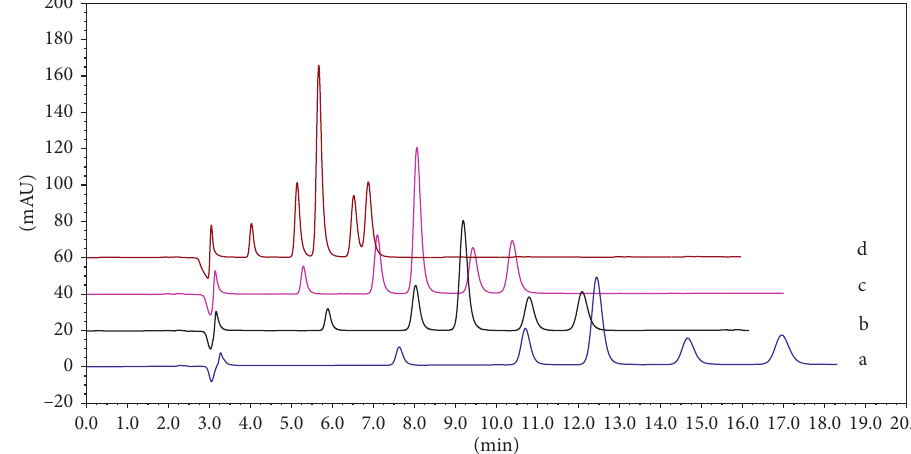
Figure 3: Typical HPLC chromatogram for simultaneous separation of ODT, GNT, TPT, AZT, and RMT. Chromatographic conditions were acetonitrile-0.05 mol · L − 1 potassium dihydrogen phosphate (phosphoric acid to adjust pH to 4.0), except the acetonitrile content was varied: (a) acetonitrile content 20; (b) acetonitrile content 25; (c) acetonitrile content 30; and (d) acetonitrile content 35. Table 1: Regression equation, correlation coefficient ( r ), linear range, and detection limit of the five 5-HT3 receptor antagonists. Compound